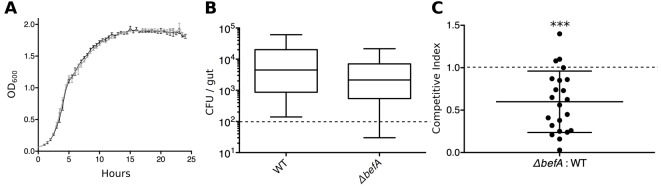
BefA confers a colonization advantage in the larval zebrafish gut.(A) Growth rates of A. veroniiWT (black trace) and A. veroniiΔbefA (grey trace) in vitro. Density measurements (OD600) were taken every half hour for 25 hours on three replicate cultures grown in Lauria broth. (B) Resulting CFU’s of A. veroniiWT (WT) and A. veroniiΔbefA (ΔbefA) within the 6dpf larval gut after inoculation with a 1:1 ratio of each strain at 4 dpf. Dashed line denotes the limit of detection. (C) Competitive index (CI) calculation for data within panel B. CI value was calculated for each fish (n=22) by dividing the ratio of mutant to WT bacteria within each gut by 6 dpf, divided by the ratio of mutant to WT bacteria used to inoculate the fish at 4 dpf. A one-sample t-test indicates that the mean CI value is significantly less than 1 (dashed line) (***t21=−3.21, p<0.0001.) A CI value of 1 is expected if no competition exists.